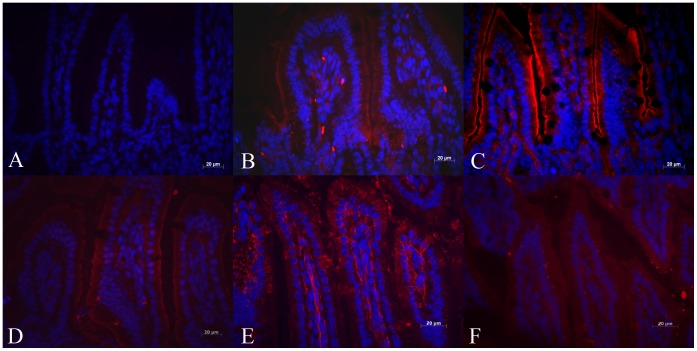
Immunohistochemical analysis of expression of fatty acid oxidation enzymes in 1-week-old wild type (OCTN2+/+) mouse jejunum.Panel A is a negative control image where there was no primary antibody and panels B–F shows immunoreactivity for MCAD, LCAD, VLCAD, SCHAD, and LKAT, respectively. All five enzymes are expressed in villous epithelial cells and minimal expression in non-epithelial cells of the villous core. (Bar represents 20 µm).